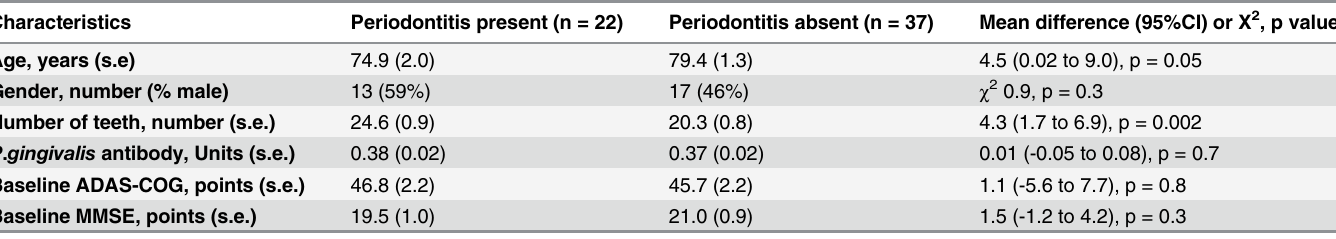
Table 1. Relationships between the presence of periodontitis and baseline demographics, other dental health measures and cognitive scores.